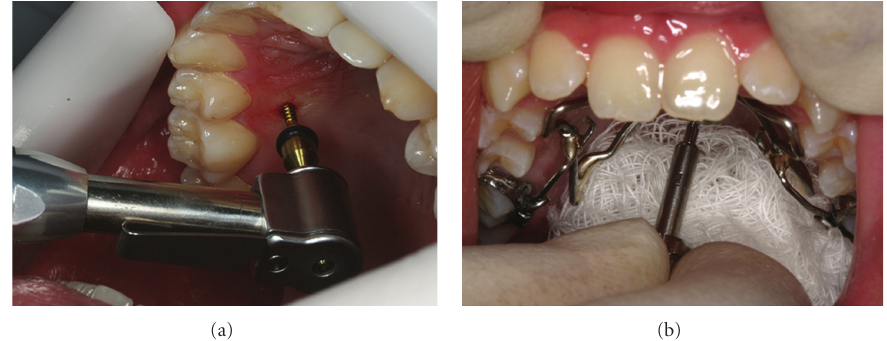
Figure 5: OI installation with the handpiece (a). OI insertion in the palate with a digital key and protection of the throat with gauze (b).